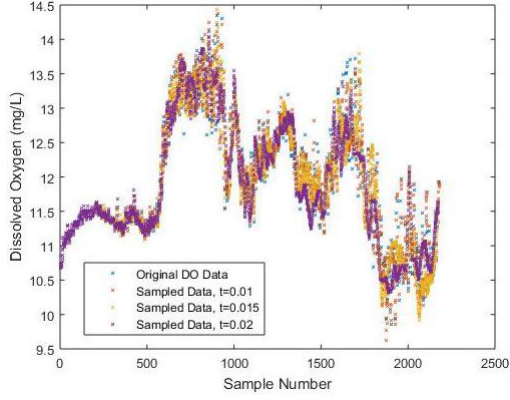
Figure 3. The difference among DO data for different sampling intervals.